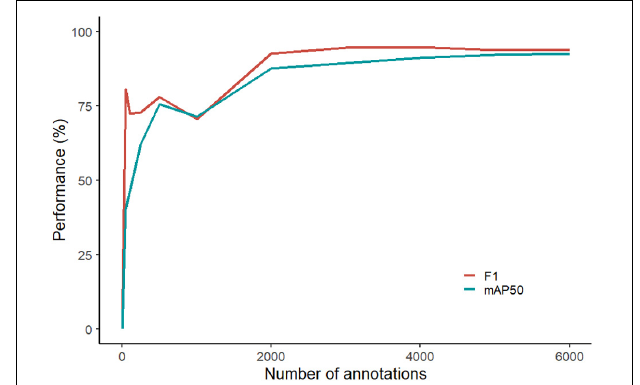
FIGURE 2 | Performance curve showing the computer’s ability to fit a segmentation mask around the luderick (performance scored by mAP50) and in accurately identifying abundance (performance scored by